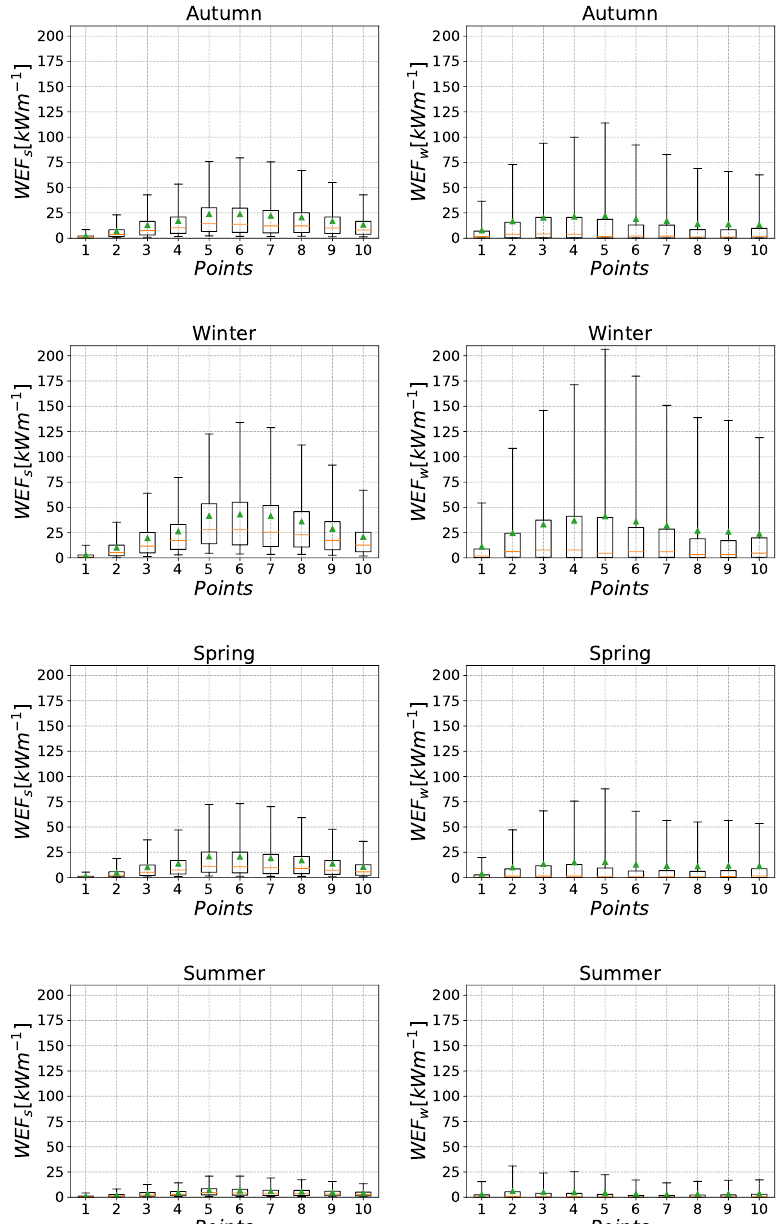
Figure 9. Seasonal boxplots for swell-induced ( left ) and wind-sea-induced ( right ) Wave Energy Flux (WEF) (kW m − 1 ) for the 10 selected offshore points